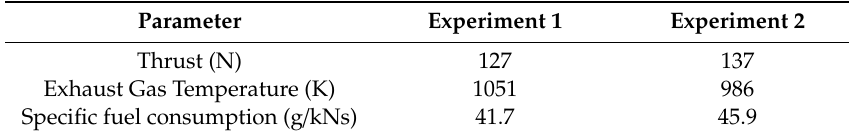
Table 2. BMT 120 KS Experimental engine performance data, taken from [8].